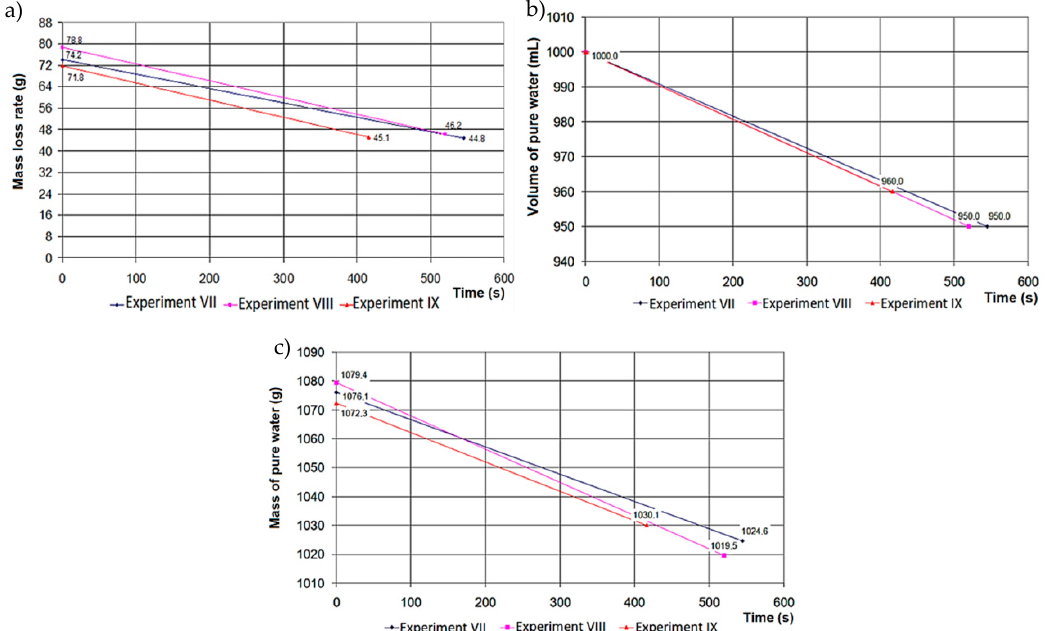
Figure 16. The changes of the mass ( c ) and volume of pure water ( b ) supplied to the gasification reactor and the mass loss rate ( a ) of the coal sample from hard coal mine C.